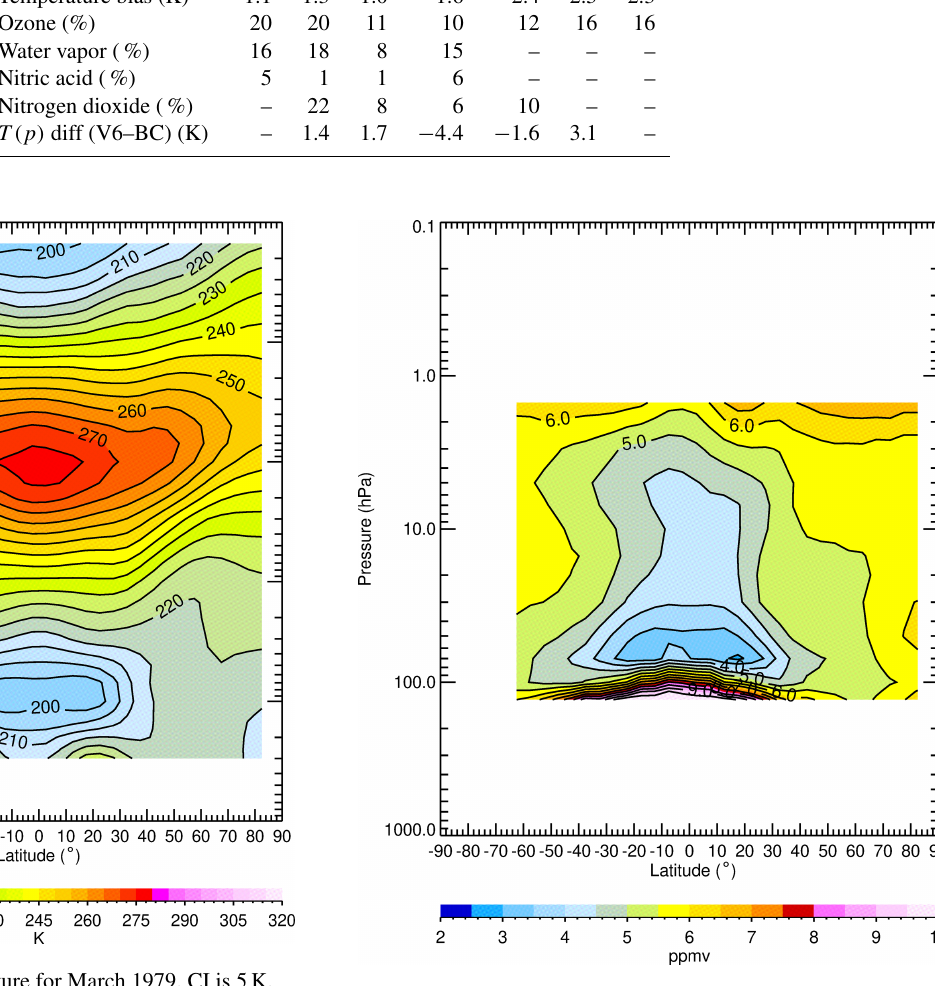
Figure 3. Zonal average water vapor for March 1979. CI is